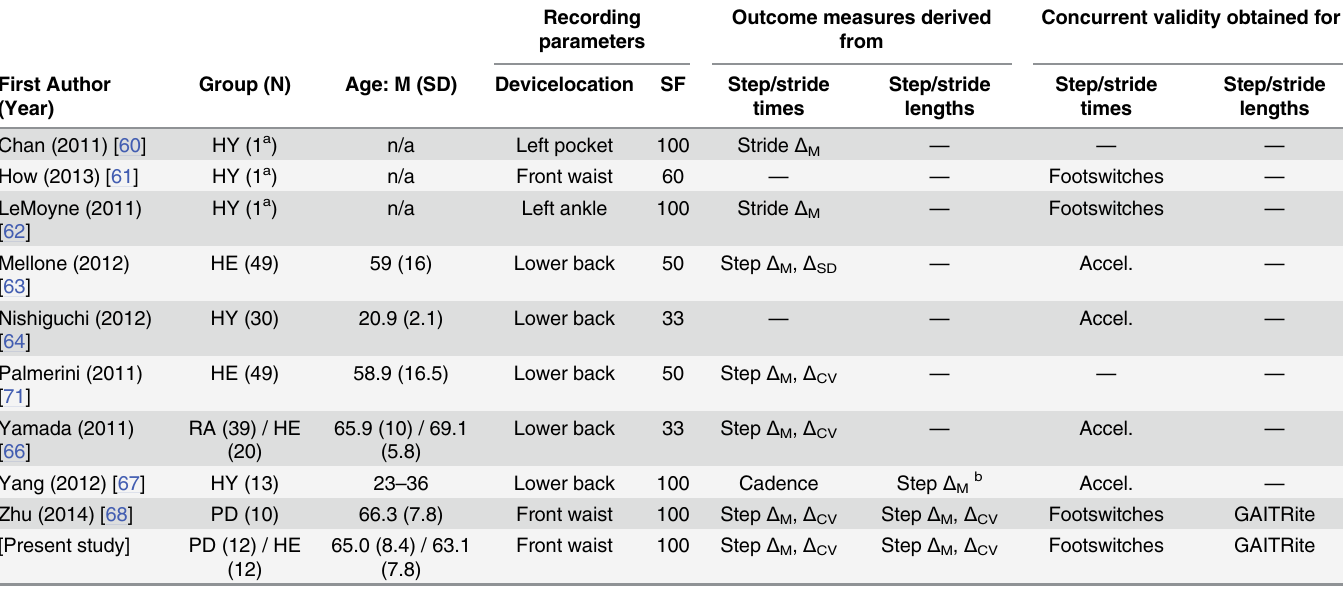
Table 1. Summary of key features of prior studies of smartphone-mediated gait analysis.